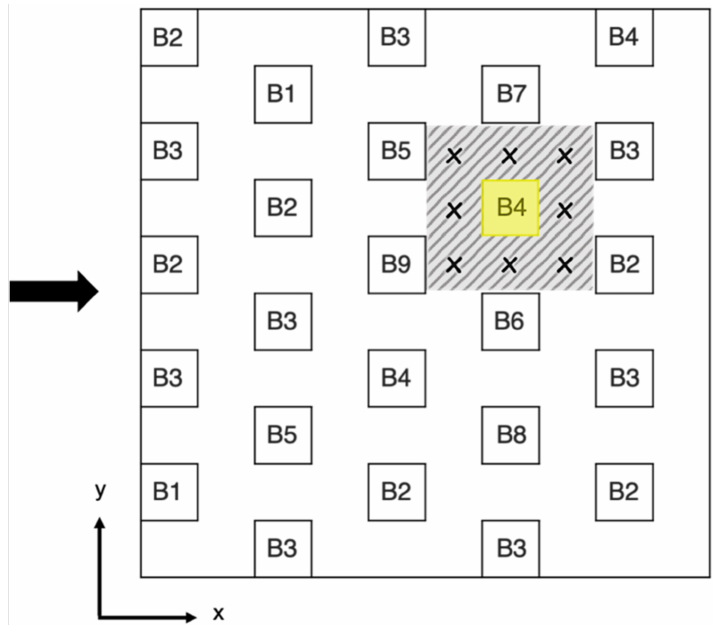
Figure 3. Example of how the local mean velocity ratio is determined around B4 for R25A ( λ p = 0.25). The arrow indicates the wind flow direction, ‘ × ’ indicates the location where the mean pedestrian- level wind velocity around a building is extracted, and building labels ‘ B1 (cid:48) to ‘ B9 (cid:48) represent different building types: B1 ( α p = 0.36), B2 ( α p = 0.84), B3 ( α p = 1.32), B4 ( α p = 1.5), B5 ( α p = 2.0), B6 ( α p = 2.64), B7 ( α p = 3.0), B8 ( α p = 3.32), and B9 ( α p =